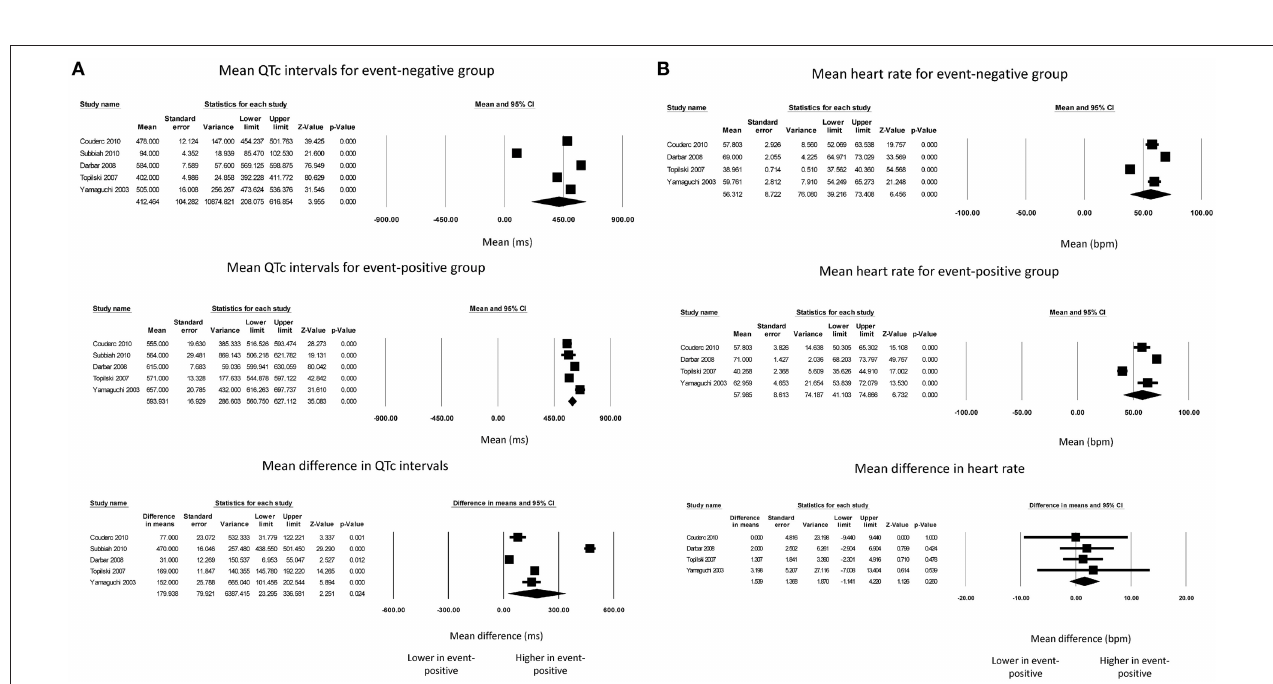
FIGURE 3 | Forest plot demonstrating the (A) mean T peak – T end intervals in the event-negative group (top panel), event-positive group (middle panel) and difference between both groups (bottom panel) in acquired QT prolongation, and (B) mean T peak – T end /QT ratios in the event-negative group (top panel), event-positive group (middle panel) and difference between both groups (bottom panel) in AV block-induced QT prolongation.